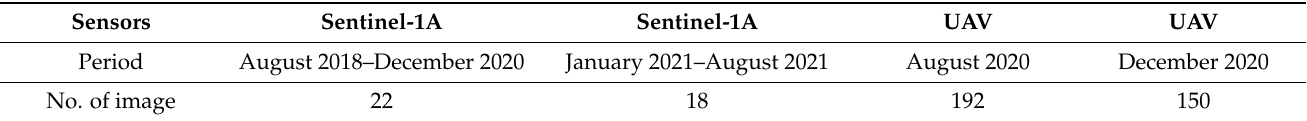
Table 1. Datasets used in this